Question: How would you classify this visualization?
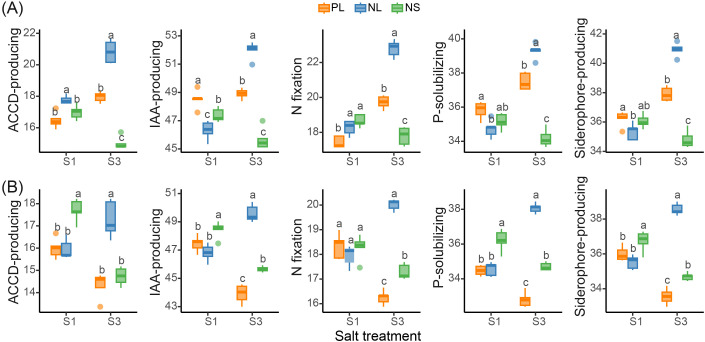
Answer: line